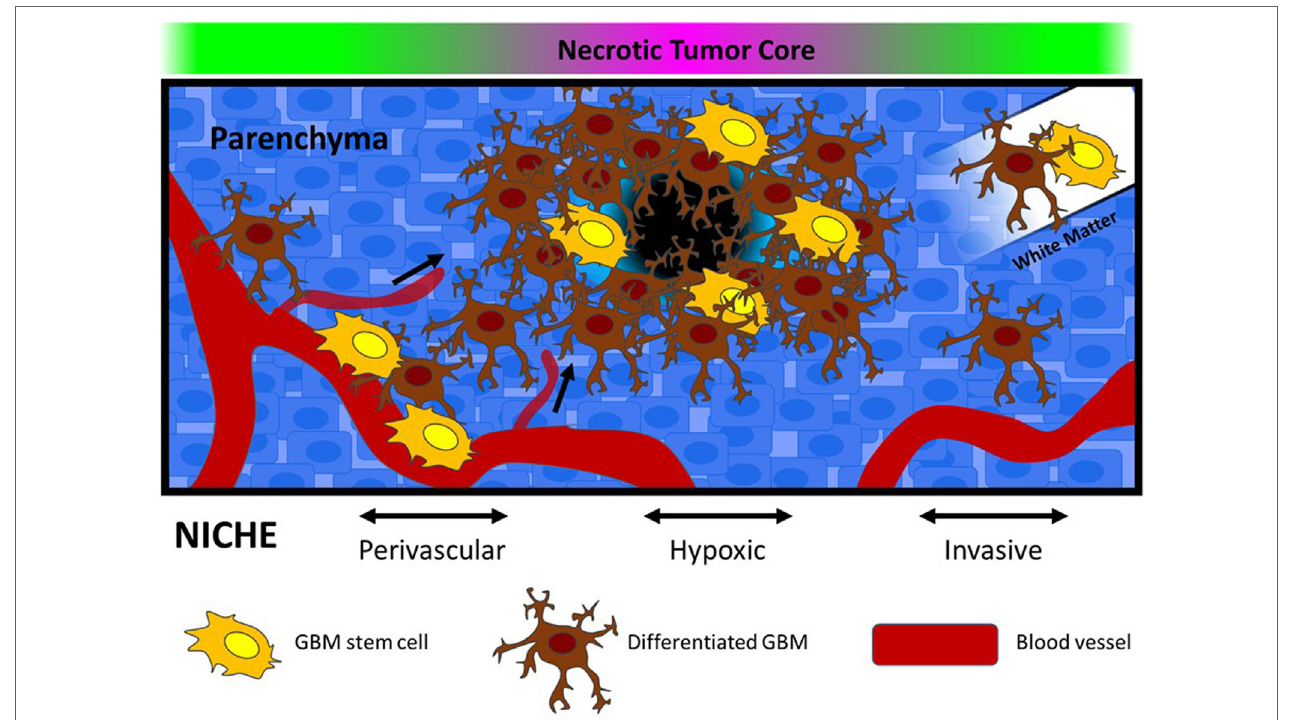
FiGURe 1 | Glioblastoma stem-like cells are located in defined microenvironments within the brain, including perivascular, hypoxic, and invasive niches. Each niche varies in terms of biophysical features (stiffness and porosity), extracellular matrix composition, and oxygen availability. In the graphic, vessel co-option is depicted within the perivascular niche, and movement along white matter tracts is depicted in the invasive niche. Within the hypoxic niche, necrosis and altered metabolism is expected to drive alterations in pH, as well as recruitment of new blood